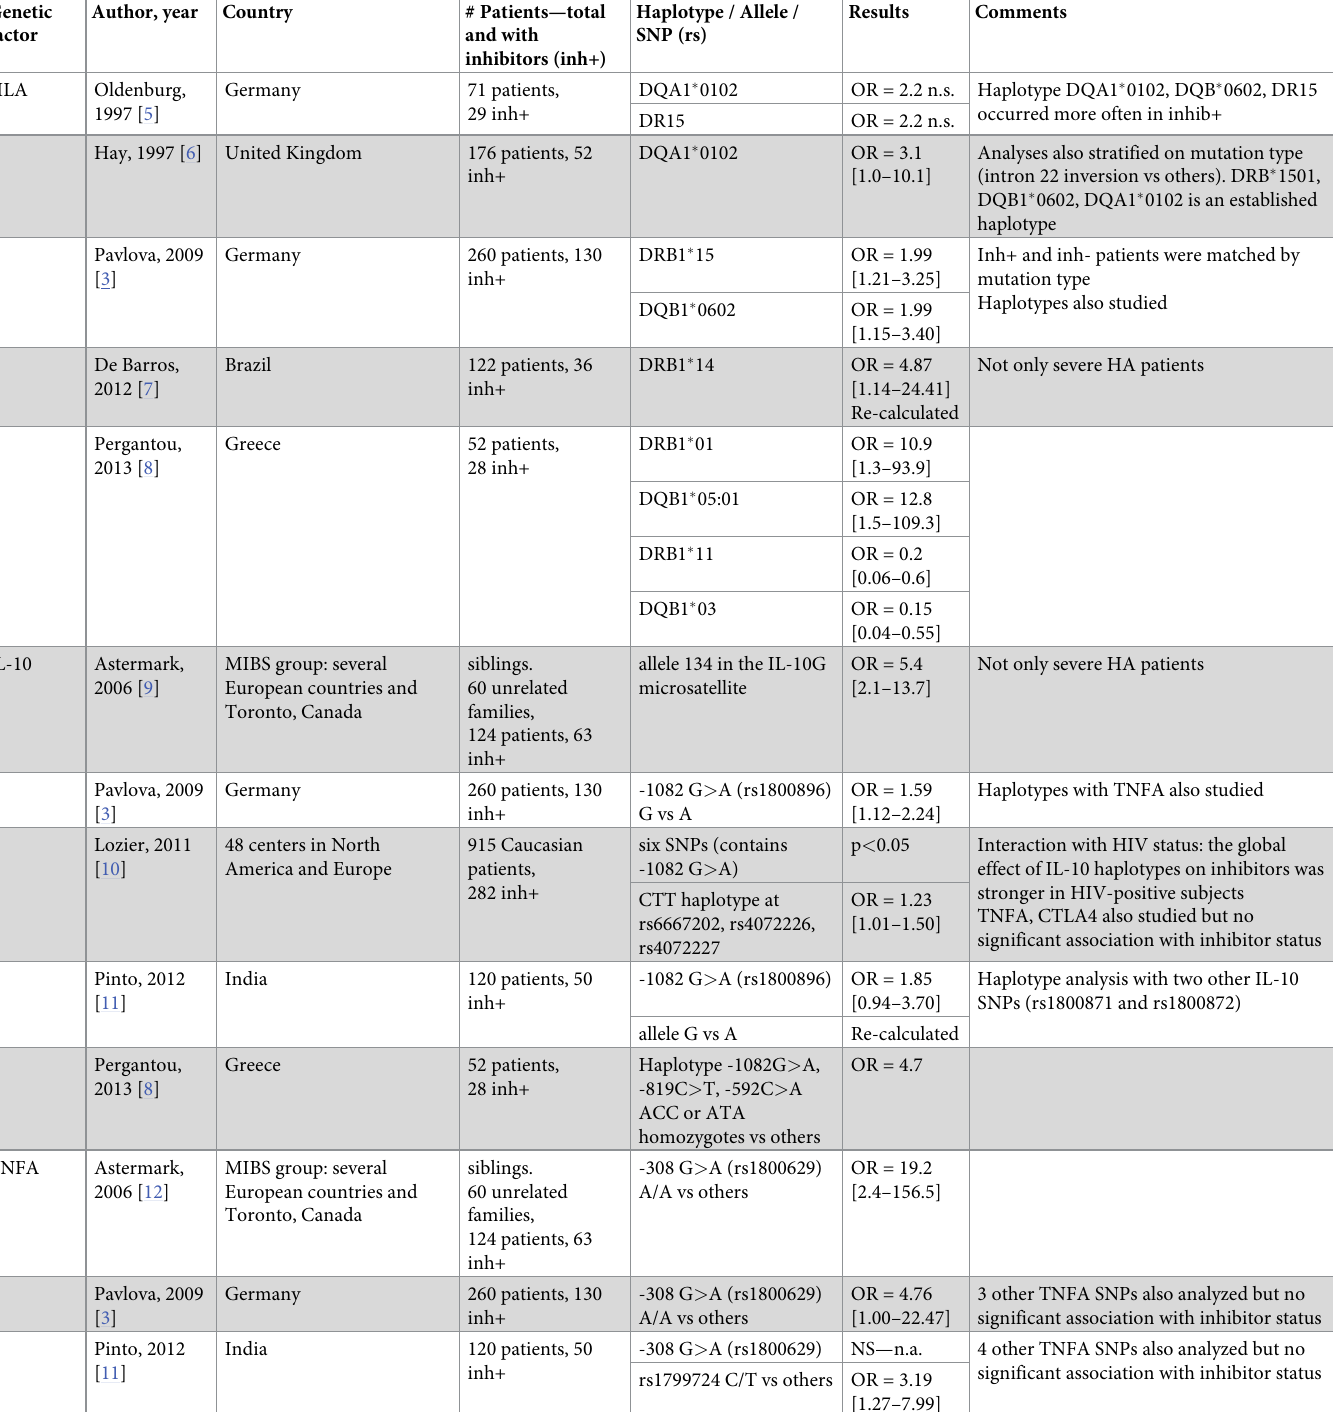
Table 1. Summary of studies finding statistically significant associations between genetic factors evaluated in the present study and inhibitor development in severe hemophilia A. Genetic